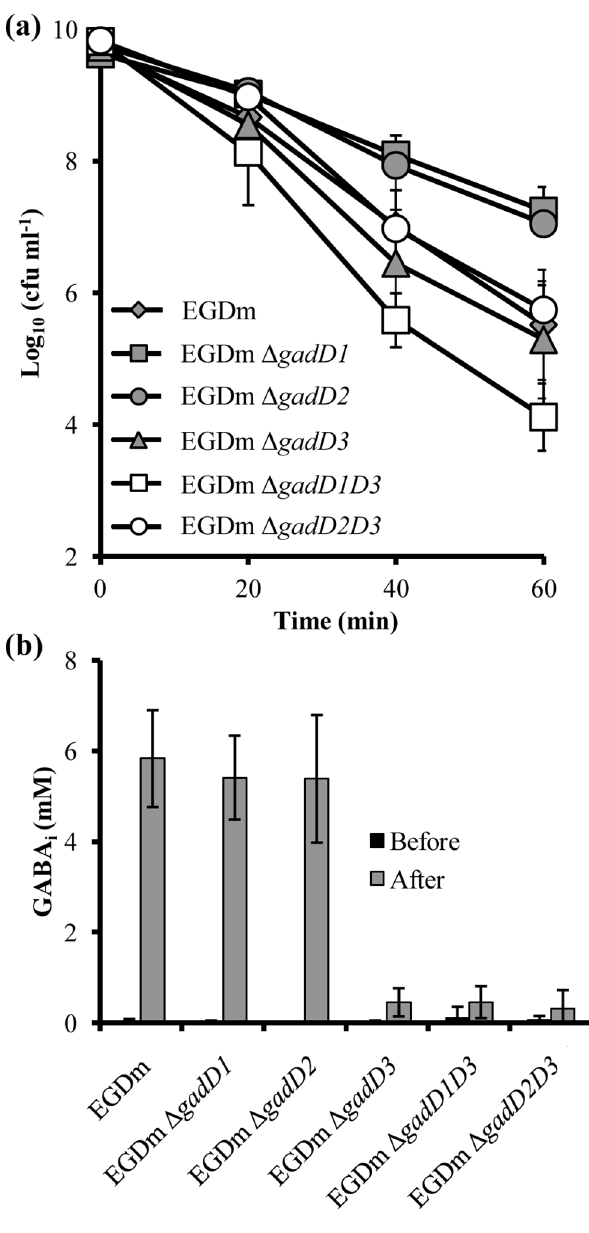
Figure 5. Acid survival and GABA i production of L.monocyto- genes EGDm double GAD system mutants indicates a key role for gadD3 . ( a ) Stationary phase EGDm gadD mutants were acidified to pH 2.5 with 3 M HCl in BHI broth. Cell counts were taken every 20 min. Values are the means of data from three individual cultures, with the cell counts for each culture being the means of counts from three platings. Error bars represent the standard deviation from the mean value for each time-point. ( b ) Stationary phase EGDm gad mutants were acidified (grey) or not acidified (black) with 3 M HCl to pH 4.0 and GABA i accumulation was quantified. Error bars represent the standard deviation from the mean of three independent biological